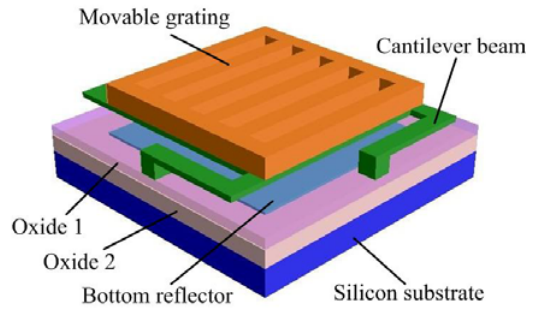
Figure 1. The structure of a single GLM.